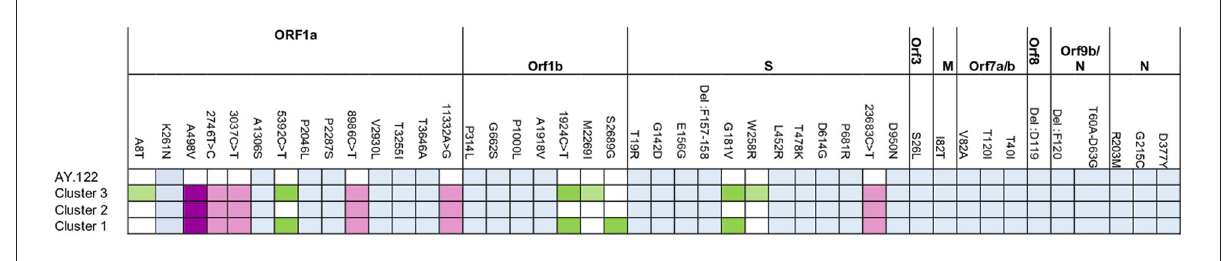
FIGURE6 Mutational profile of Tunisian sequences from Cluster 1, 2 and 3 in comparison with the AY.122 sub-lineage.